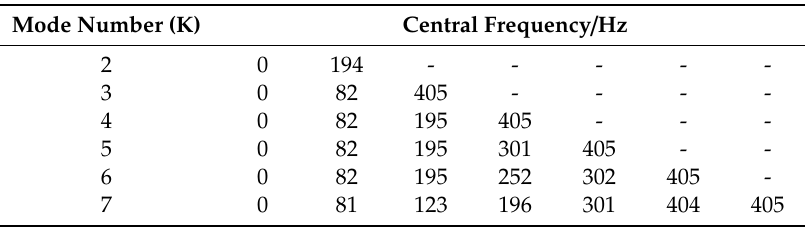
Table 1. The central frequency corresponding to different K values.